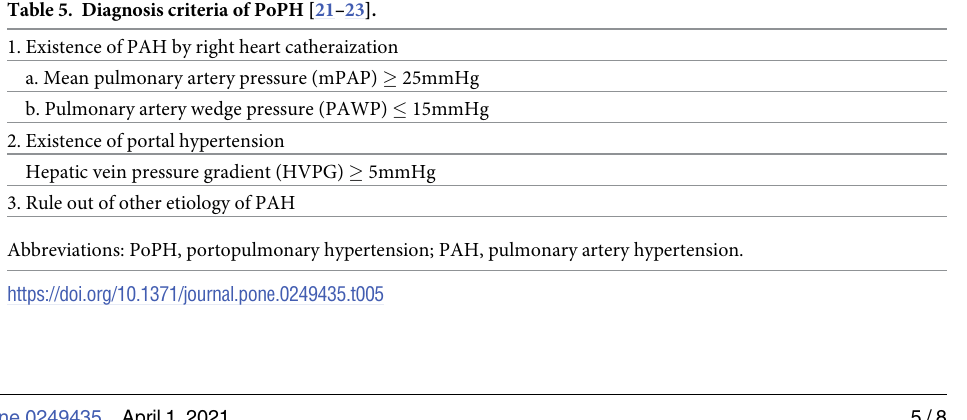
Table 4. Echocardiographic signs suggesting PAH used to assess the probability of PAH in addition to tricuspid regurgitation velocity measurement in Table 3 [21]. A: Ventricles B: Pulmonary artery C: Inferior vena cava and right Right ventricle:left ventricle basal diameter ratio > 1.0 Flattening of the interventricular septum (left ventricular eccentricity index > 1.1 in systole and/or diastole)